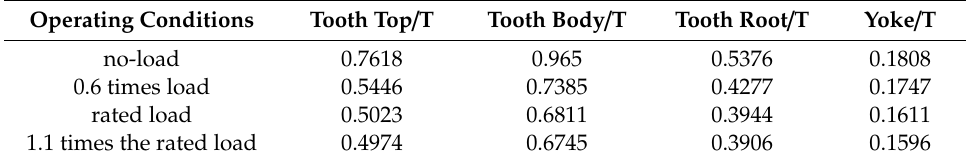
Table 4. Average magnetic density of each area on the stator side under four operating